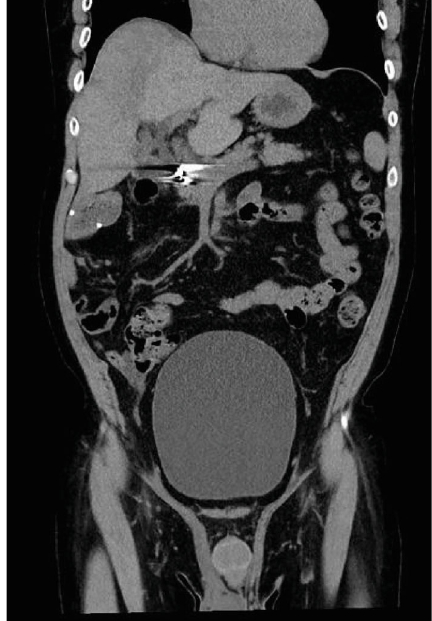
Figure 1: Noncontrast CT abdomen in coronal plane demonstrates enlarged bladder to the level of the umbilicus.